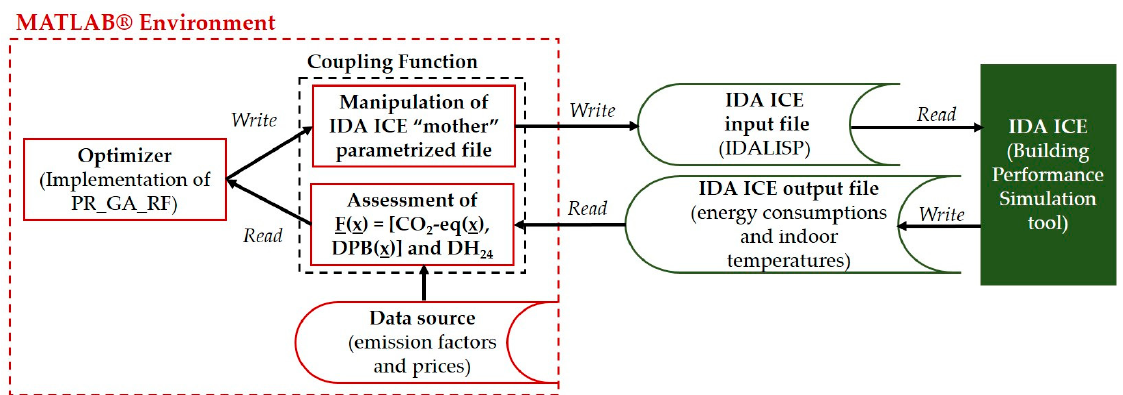
Figure 1. Optimization scheme: coupling between MATLAB ® and IDA ICE.